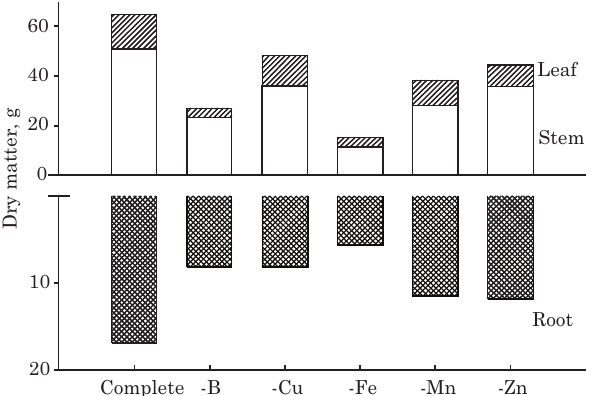
Figure 1. Dry matter yield of plant parts of physic nut, grown in complete nutrient solution and in absence of B, Cu, Fe, Mn, and Zn.